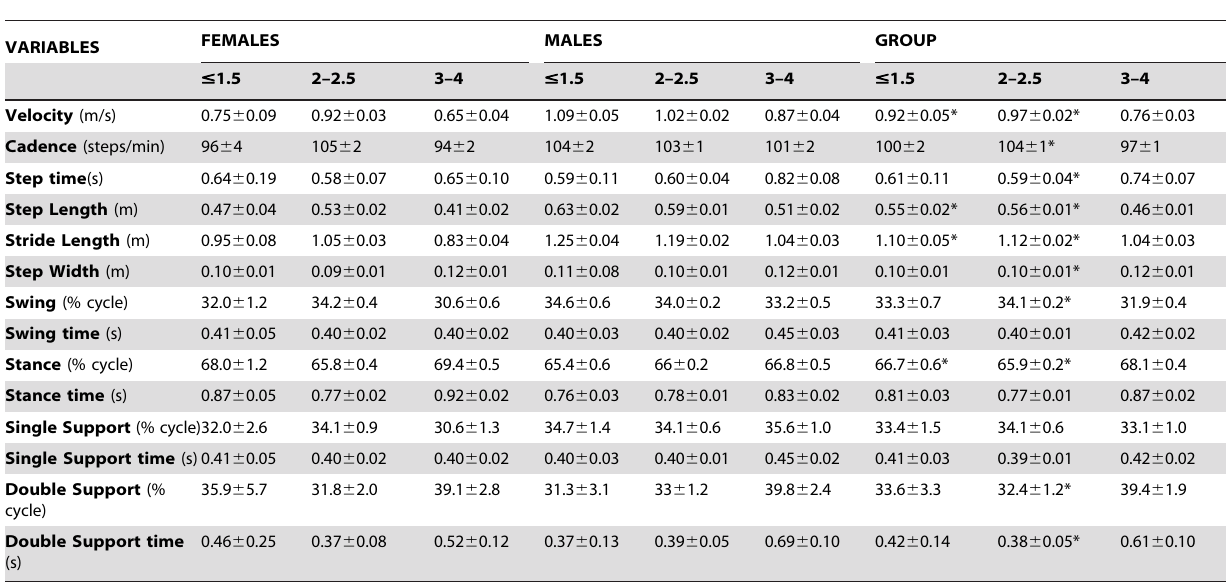
Table 2. Gait Spatiotemporal Variables of Interest (values as reported as mean 6 SD).